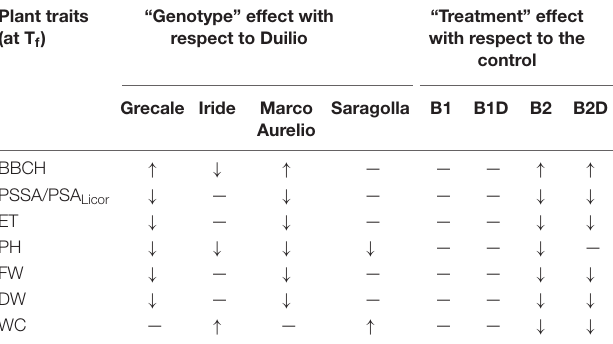
TABLE 7 | Schematic representation of the genotype effect on the analyzed plant phenotypic traits at the end of the experiment (T f ) in terms of increase or decrease of the trait value with respect to Duilio, on the left side, and of the biochar treatment effect with respect to the control, on the right side. Plant traits (at T f